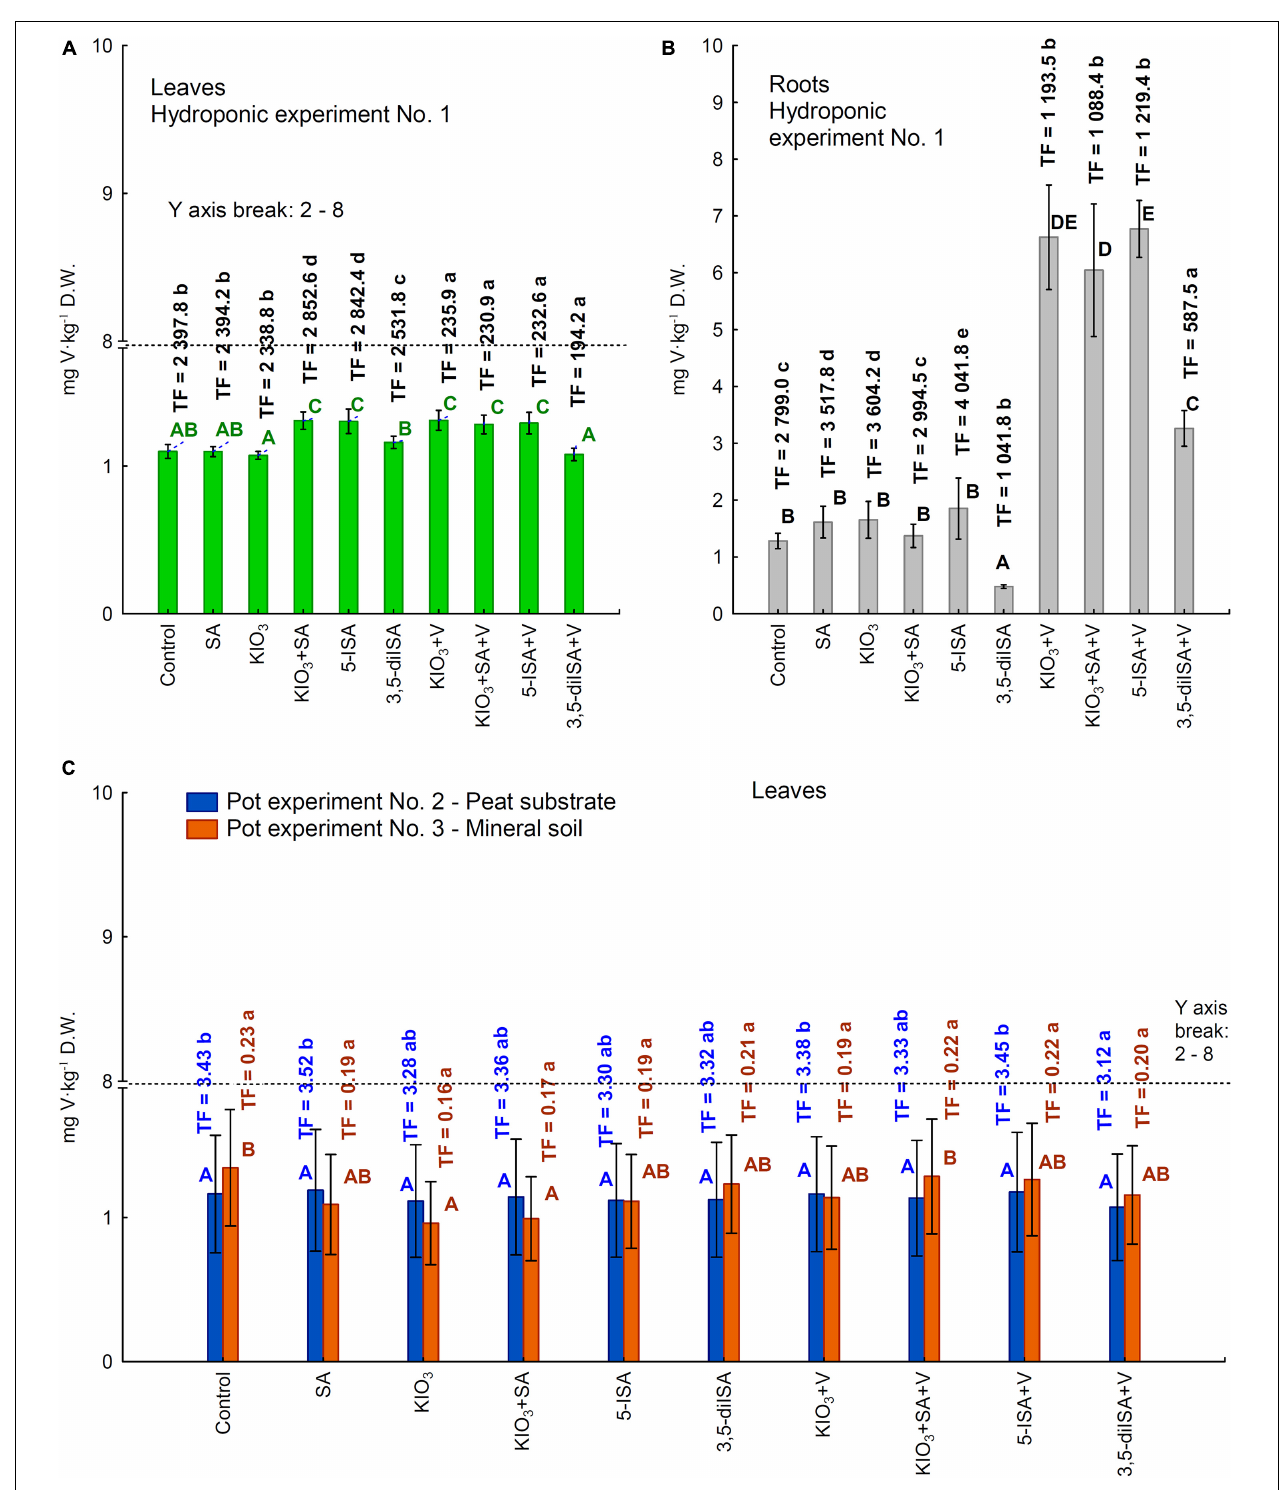
FIGURE 3 | Concentrations of vanadium in leaves /heads/ (A) and roots of lettuce (B) cultivated in hydroponic NFT Experiment No. 1 as well as in leaves of plants cultivated in pot Experiment No. 2 and 3 (C) . Transfer factor /TF/ of vanadium to roots and leaves /heads/ in the all experiments. Means followed by different letters for treatments, separately for each experiments differ significantly at P < 0.05. Color-coded capital letters for vanadium content (green and gray for leaves and roots in Experiment 1 and blue and orange for leaves in Experiments 2 and 3); lowercase letters in the same colors for the TF factor in these experiments. Bars indicate standard error ( n =